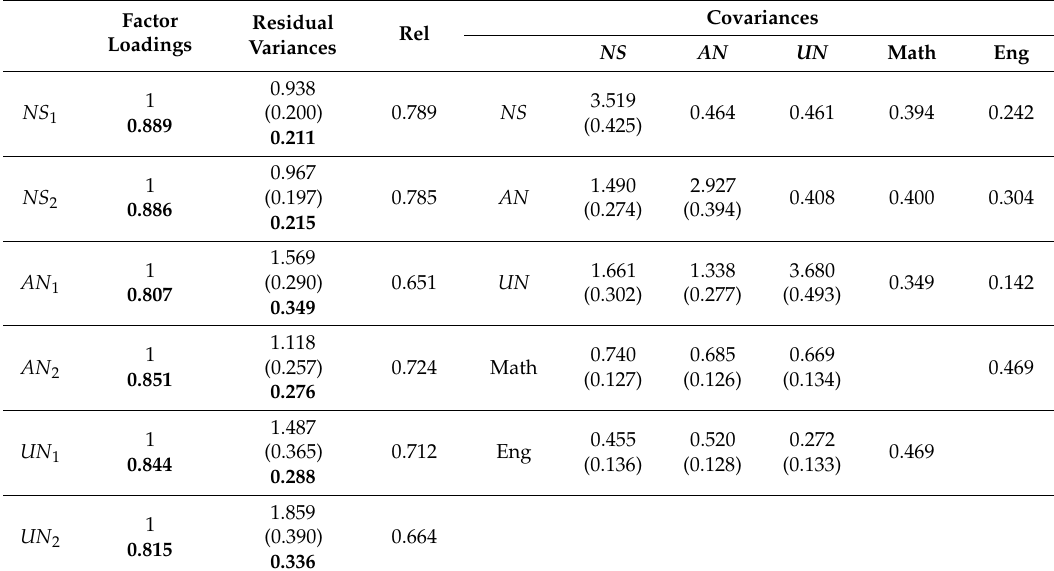
Table 4. Estimates of the Model with Correlated First-order Factors and Grades.